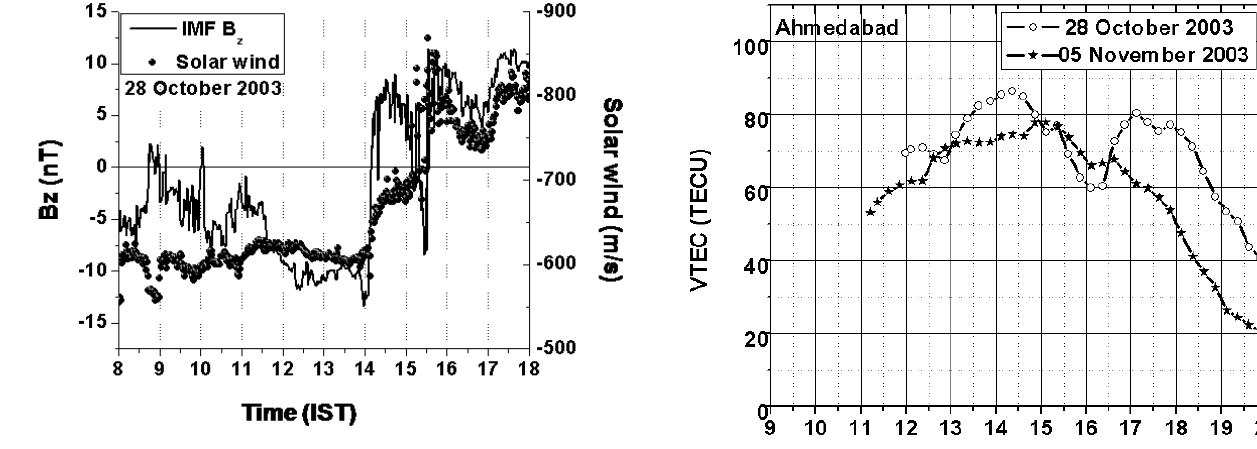
Fig. 3. Temporal variations of IMF B z and solar wind velocity on 28 October 2003.